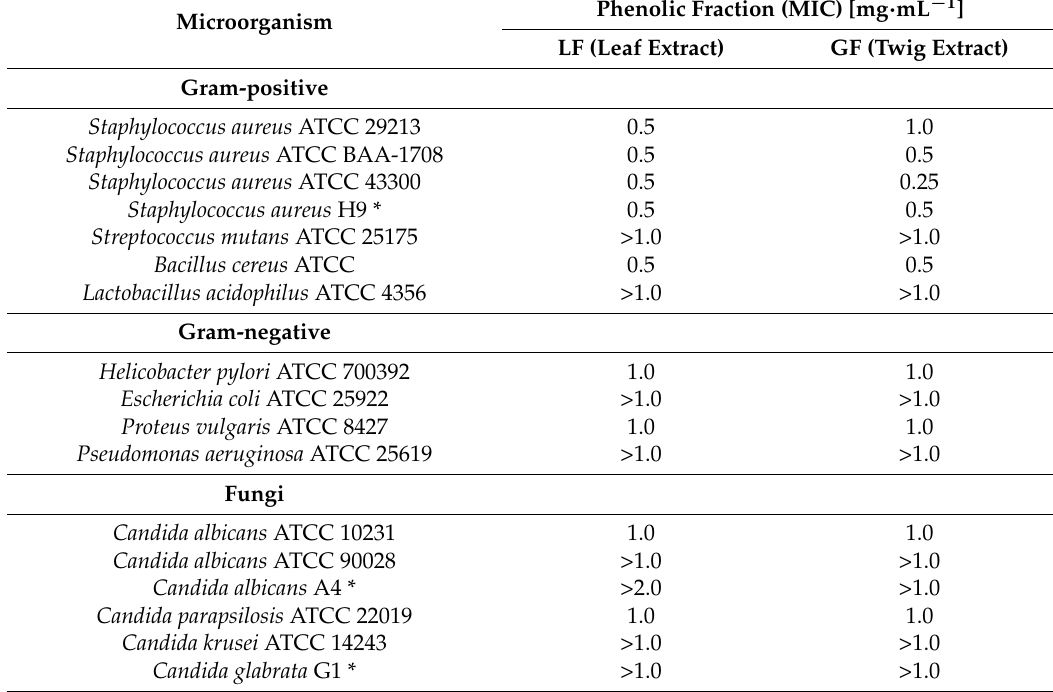
Table 2. The antimicrobial activity of fractionated Sea buckthorn extracts. Minimal inhibition concentration (MIC) measured by broth microdilution